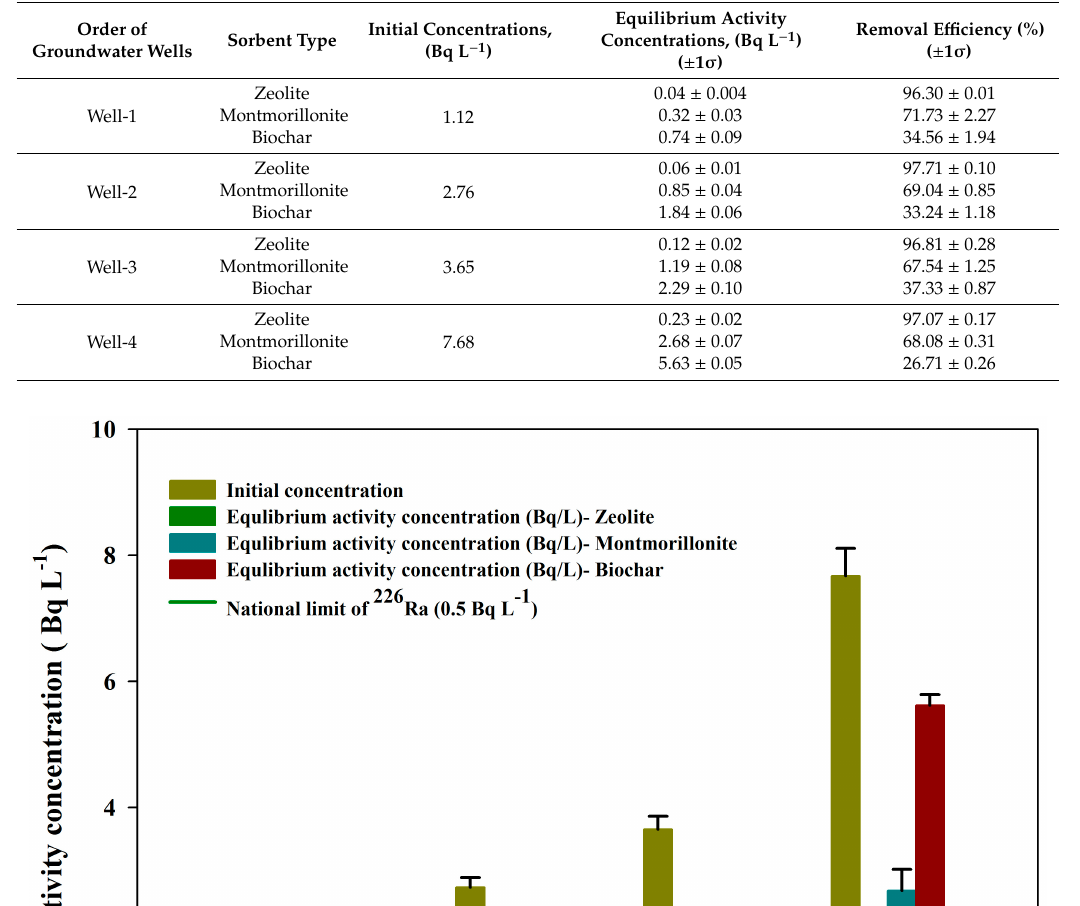
Sorbent e ff ects on equilibrium activity concentrations and removal e ffi ciency of contaminated groundwater.